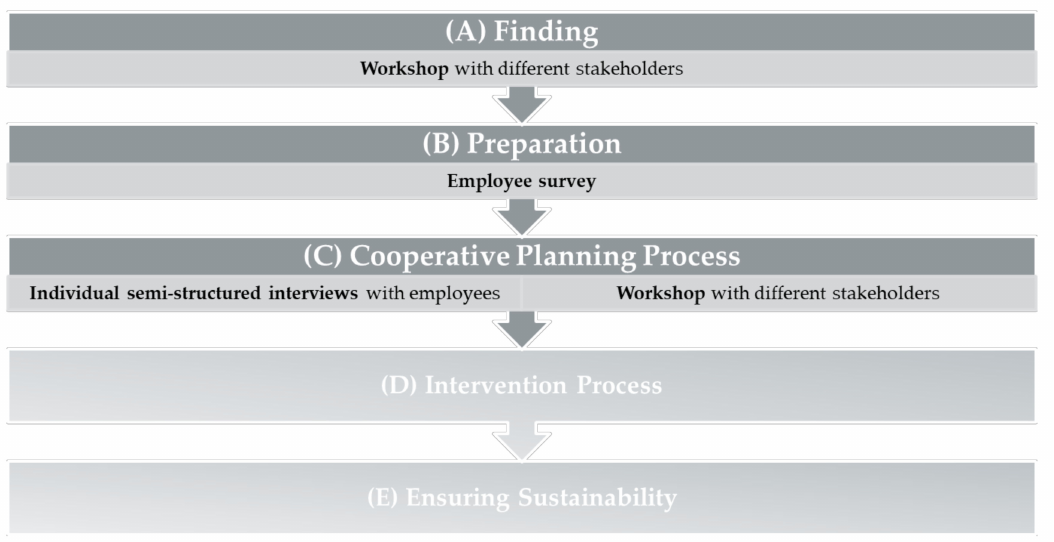
Figure 1. Methodical approach of the study within the framework of the BIG-Manual